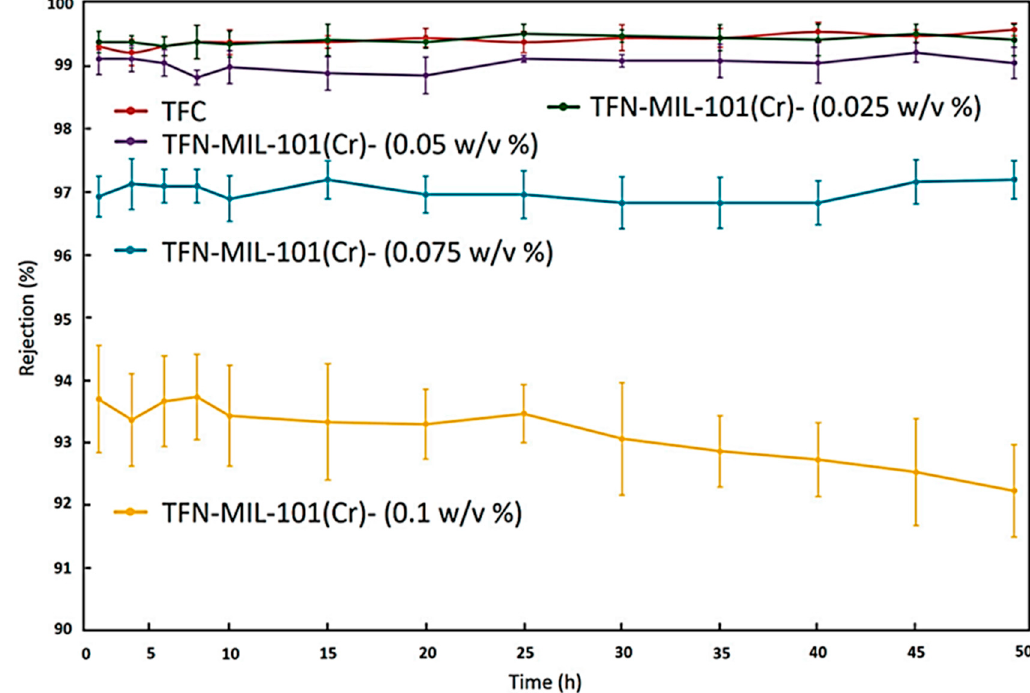
Figure 10. Stability test results of the TFN filled with MIL-101(Cr) at 2000 ppm NaCl aqueous solution at 16 bar and 25 °C for 50 h [40].